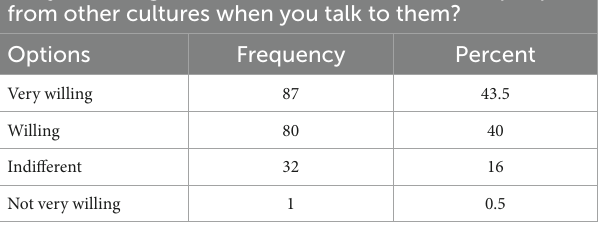
TABLE 4 Participants’ willingness to introduce Chinese culture. Are you willing to introduce Chinese culture to people from other cultures when you talk to them?